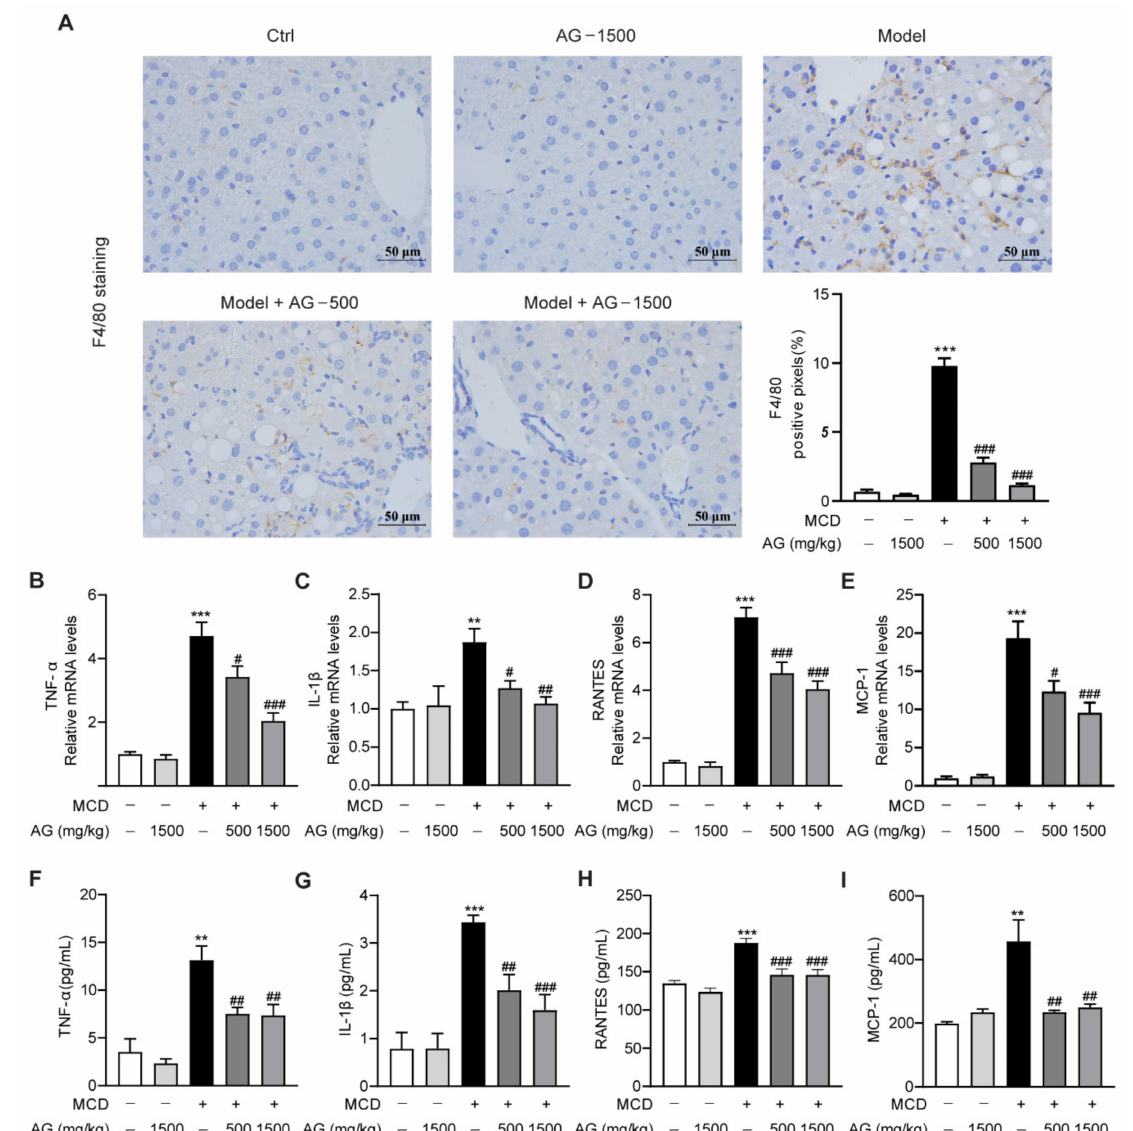
Figure 4. Effects of Ala-Gln on inflammatory response in the liver of MCD-fed mice. ( A ) Repre- sentative images for F4/80 staining ( × 400) in the liver section and quantitative results. ( B – E ) The mRNA levels of TNF- α , IL-1 β , RANTES, and MCP-1 in liver. ( F – I ) The protein levels of TNF- α , IL-1 β , RANTES, and MCP-1 in plasma. Data are expressed as the mean ± SEM. ** p < 0.01, *** p < 0.001, compared to the Ctrl group; # p < 0.05, ## p < 0.01, ### p < 0.001, compared to the Model